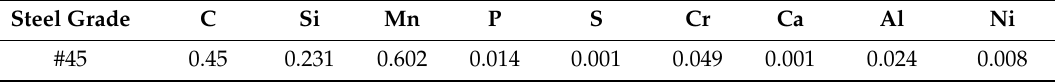
Table 1. Chemical composition of the 45# steel material (weight percent).